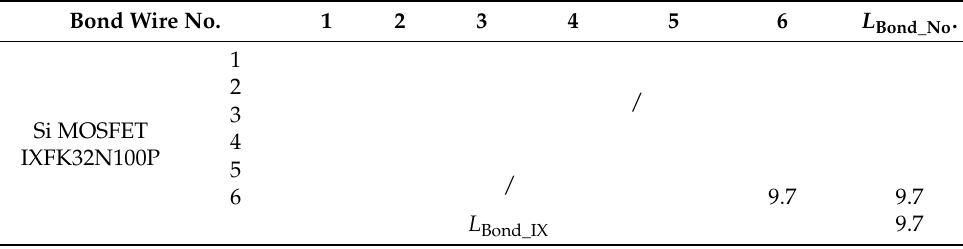
Table A4. Parasitic inductance, L Bond , with five bond wire cutoffs. Bond Wire